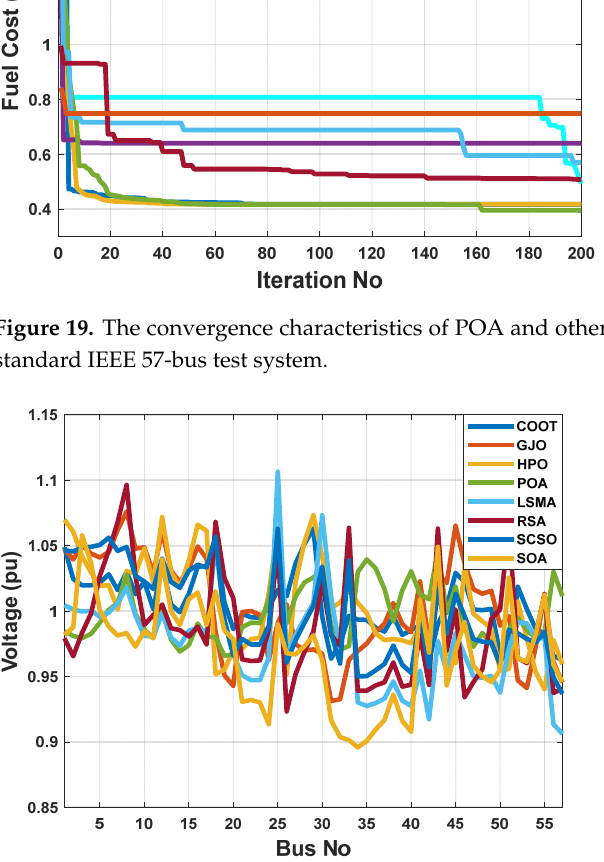
Figure 20. The voltage profile of the POA and other compared algorithms for case 1 in a standard IEEE 57-bus test system.